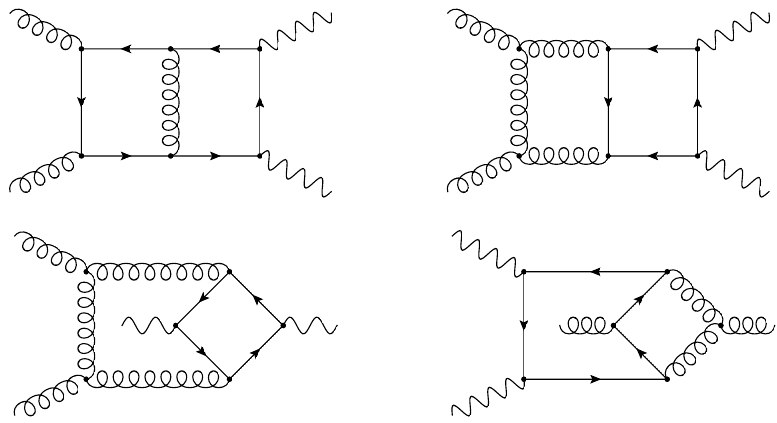
Figure 1. Examples of diagrams contributing to the virtual